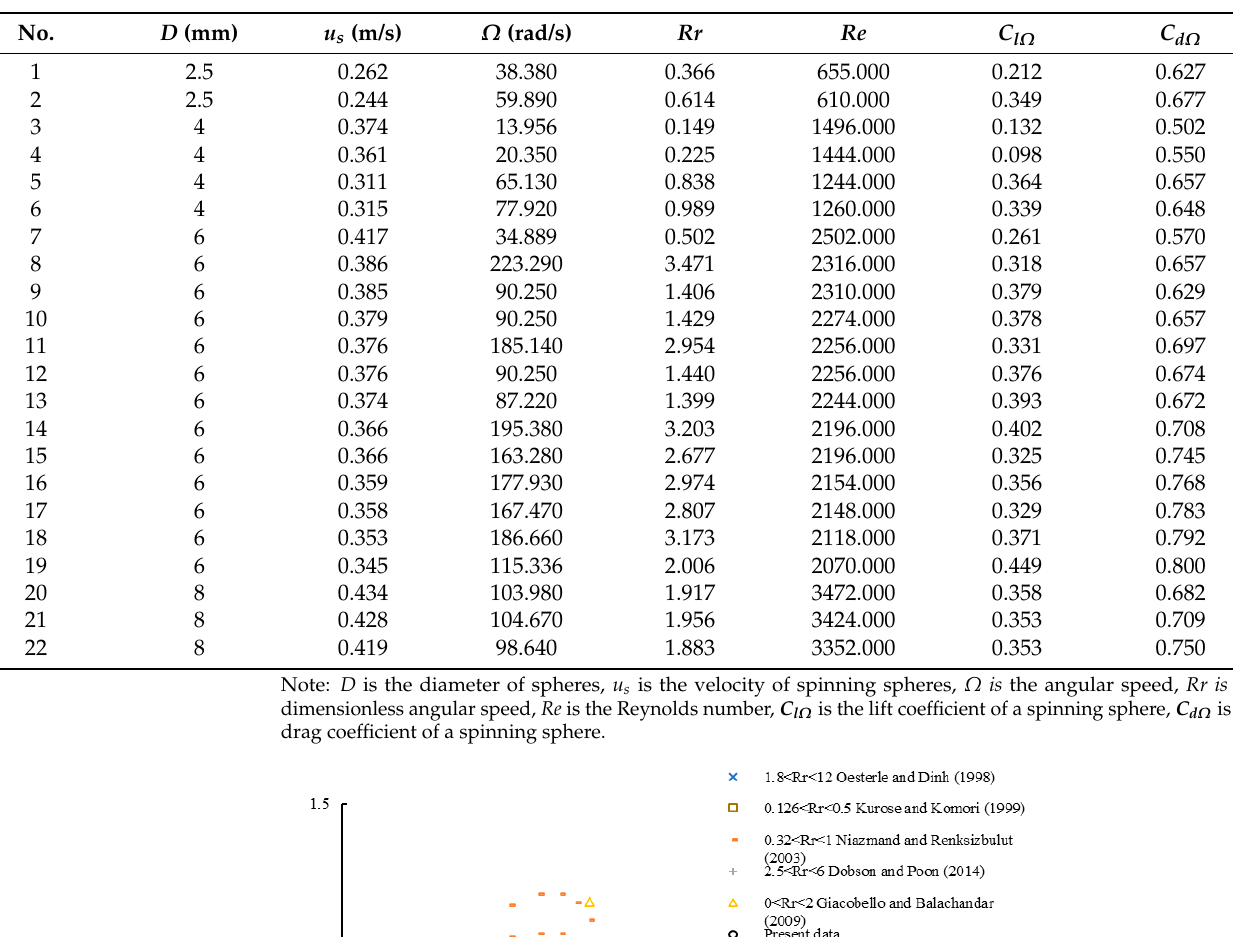
Table 2. Experimental results.